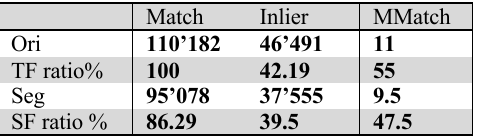
Table 4. Average (Avg) of matches from 50 strongest points and averaged (AVG) of the miss matches (MMatch). Absolute value with (relative value, %) for each case respectively.